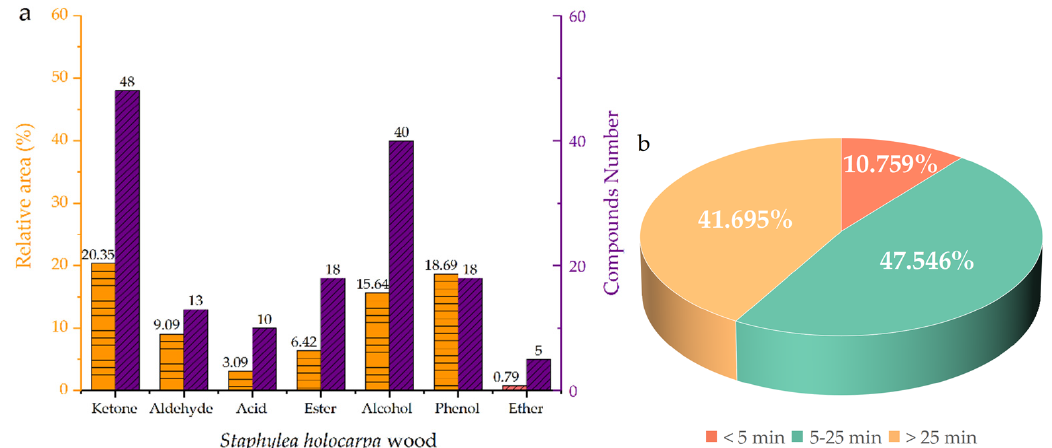
Figure 5. Classification ( a ) and temporal ( b ) distribution of pyrolysis products from S. holocarpa wood.